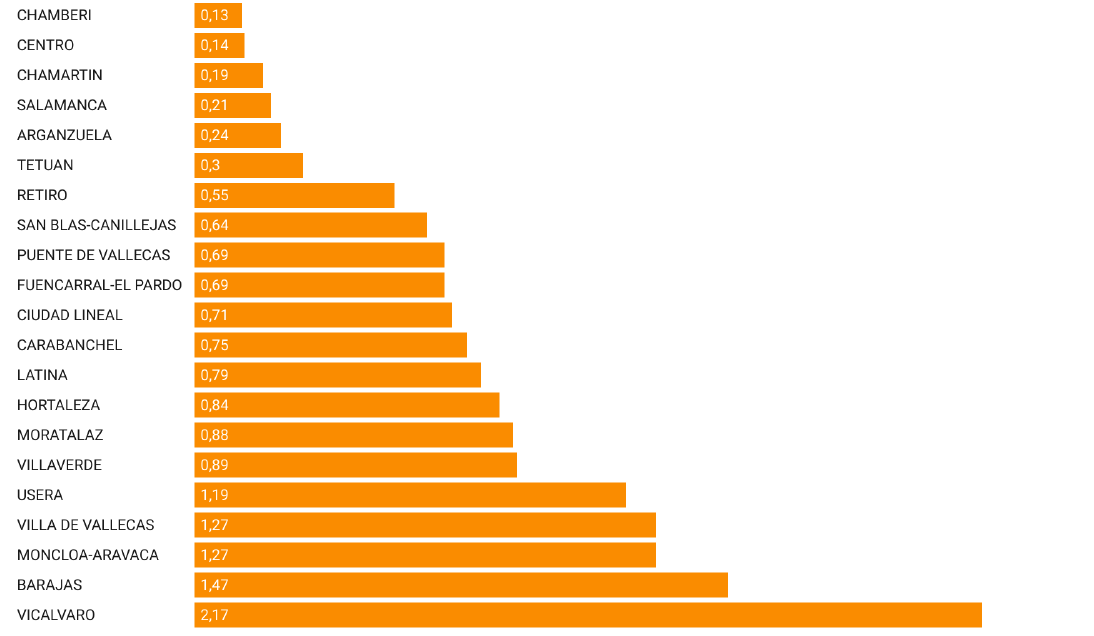
Figure 3. Ratio of benches per terrace seat per district in Madrid, 2022. Source: Madrid City Council, 2022.